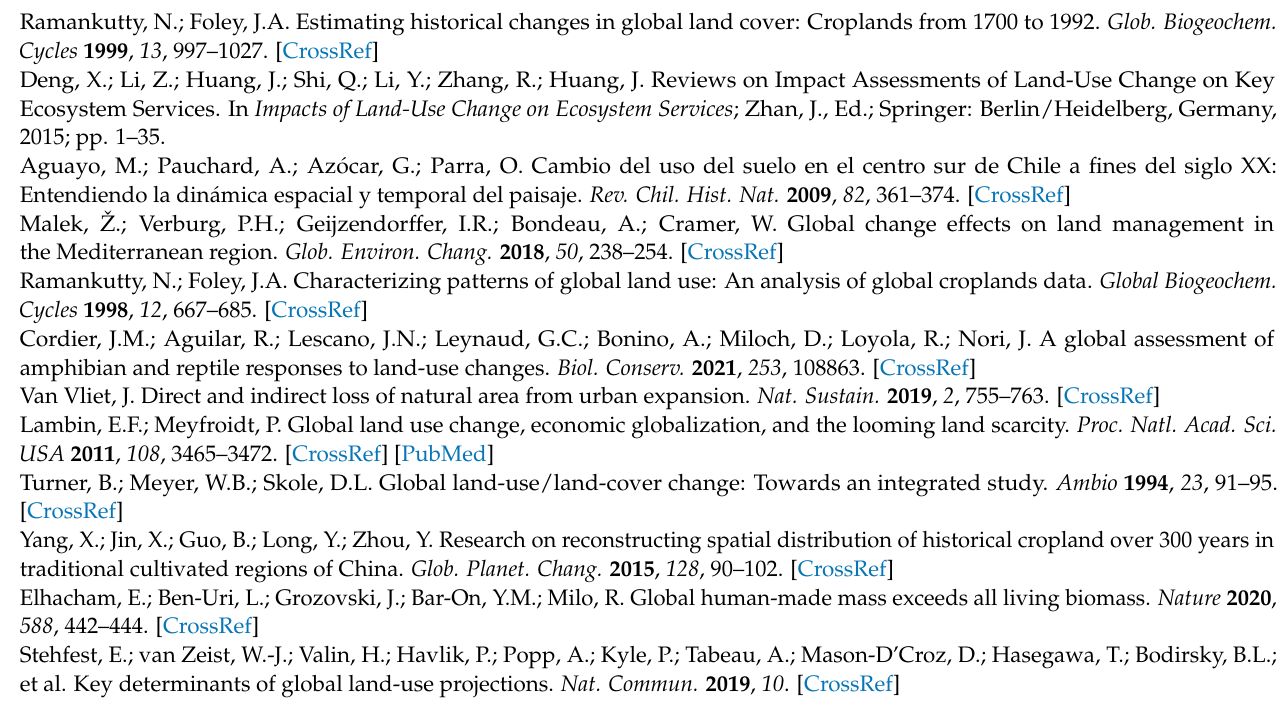
and promote ecosystem protection. Figure S2. The proportion of expected change by 2080 according to the Land-Use Harmonization (LUH2) Project. Figure S3. Main LULC transitions (percentage %) simulated between 1992 and 2080 for the RCP 2.6, 4.5, 6.0, and 8.5 scenarios. Figures S4–S18. LULC change (2080) within the protected area network by region in Chile. Table S1. Bioclimatic and topographic variables. Figure S19. Distribution of LULC change projections within the protected area network. Figure S20. Expected change for each category assigned according to the Land-Use Harmonization (LUH2) Project. Figure S21. Comparison of the range of changes between RCP 2.6 (by 2030) and RCP 8.5 (by 2080). Figure S22. Ecosystem area trajectory by 2030, 2050, and 2080 for RCPs 2.6, 4.5, 6.0, and 8.5. Table S2. Transitions (ha and percentage of the area) between categories by scenario in the protected area network in Chile. Table S3. Comparison of surface area (in ha) between models with and without anthropic areas due to LULC change (current scenario; 2050, RCP 6.0; and 2080, RCP